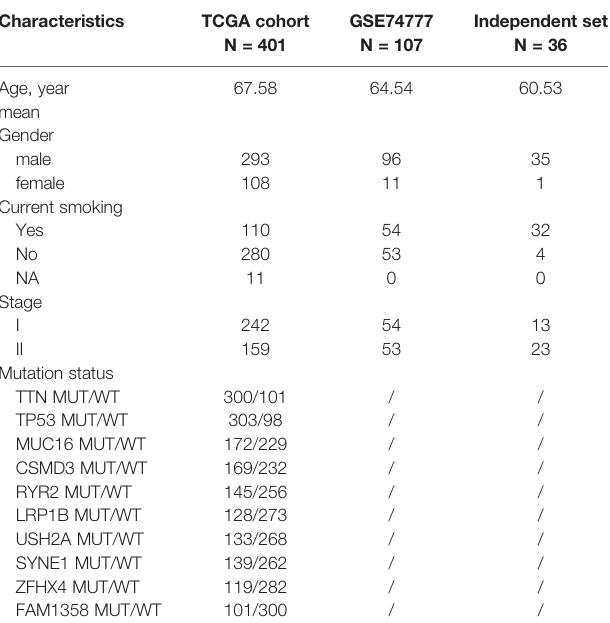
TABLE 1 | Clinical characteristics of early stage lung squamous cell carcinoma.